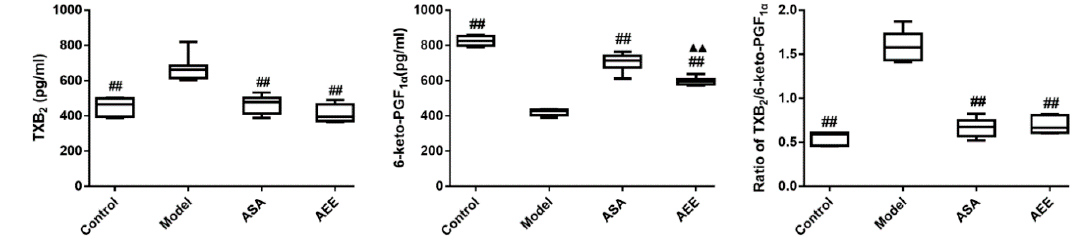
Figure 2. Effects of AEE on TXB 2 and 6-keto-PGF 1 α levels. TXB 2 : thromboxane B 2 . Compared with the model group, ## p < 0.01; compared with the ASA group, ▲▲ p < 0.01.